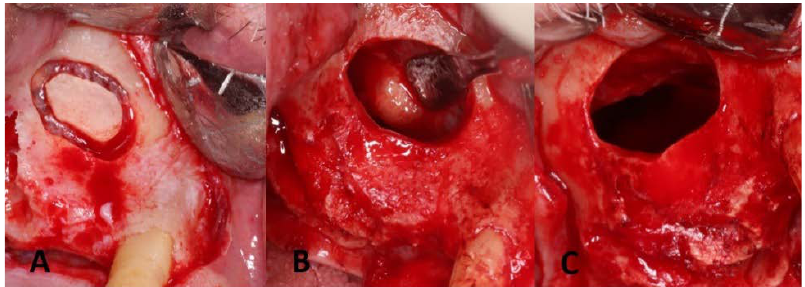
Figure 3. Lateral window preparation and the maxillary sinus cyst removal: ( A ) lateral window preparation with Piezo surgery; the bony island was detached and saved in saline; ( B ) sinus membrane after elevation and identification of the antral pseudocyst; ( C ) sinus membrane perforation after specimen removal.